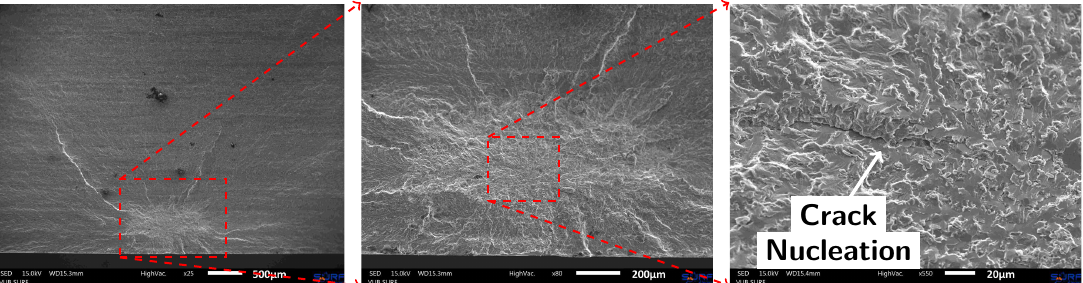
Figure 6. SEM images of the fracture surface of Specimen 3 (wrought material without capillaries). The fatigue crack initiated from an internal defect near the bottom of the